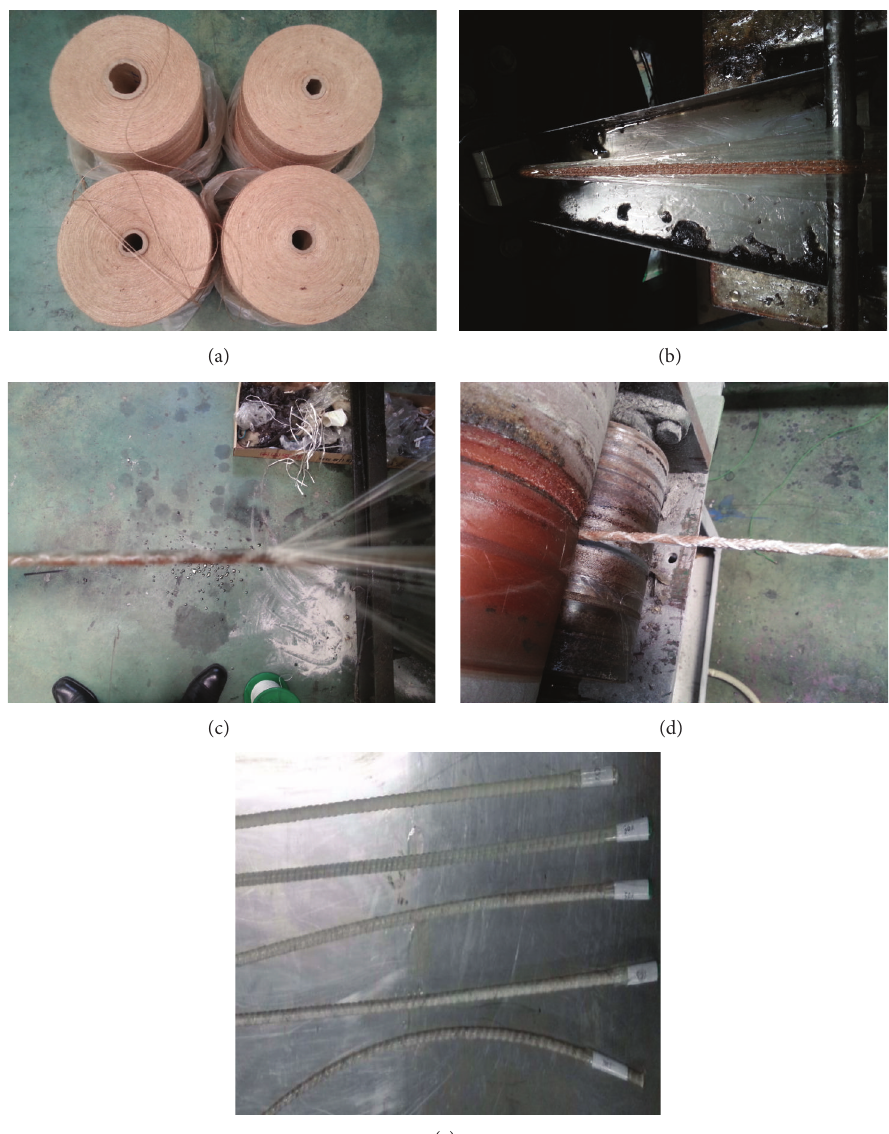
Figure 2: Manufacturing of HGJFRP composite bar. (a) Jute fiber. (b) Impregnation. (c) Braiding. (d) Pultrusion. (e) Geometry of HGJFRP composite